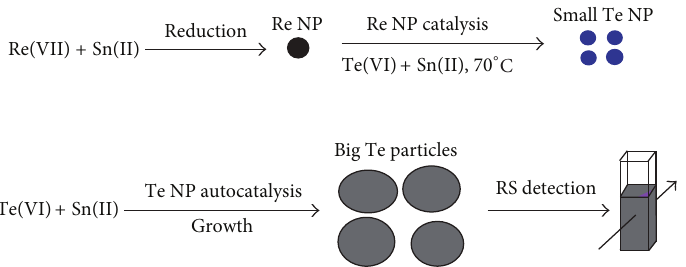
F 1: Analytical principle of the nanocatalytic RS method for Re.